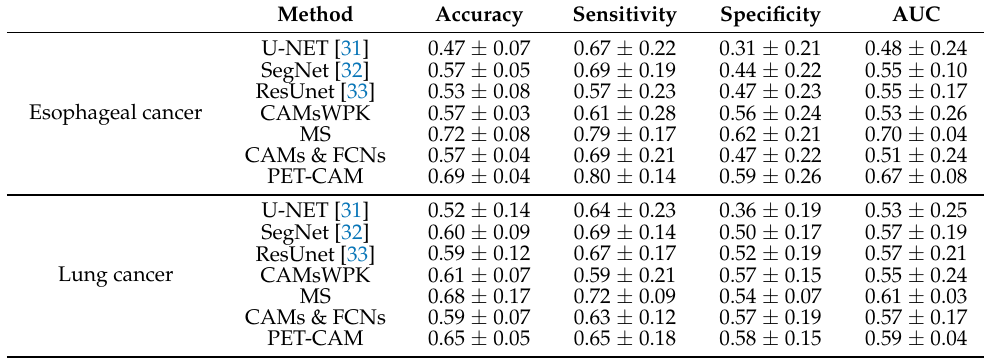
Table 2. Results for radiomics analysis. WPk: without prior knowledge. Ms: manual segmentation.